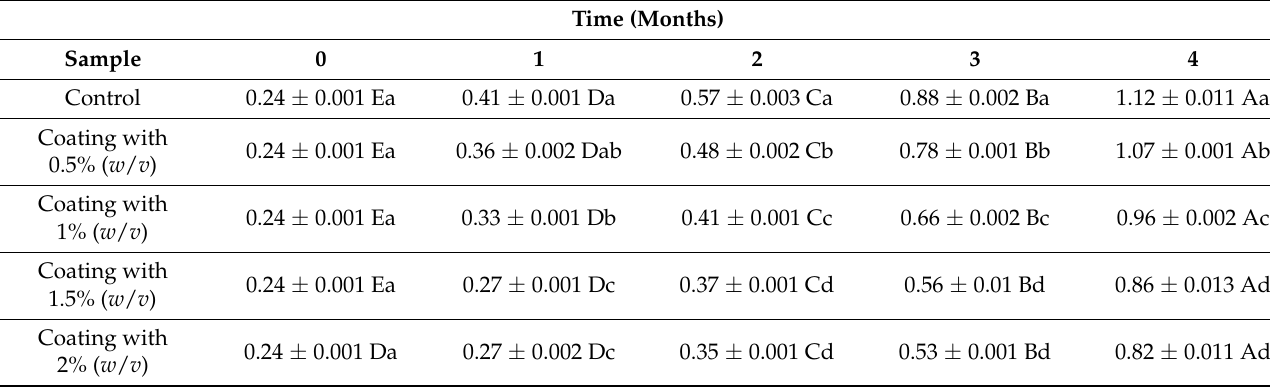
Table 2. Changes in the peroxide value of uncoated (control) and coated almonds during 4 months of storage in mill equivalents of oxygen per kilogram of oil.